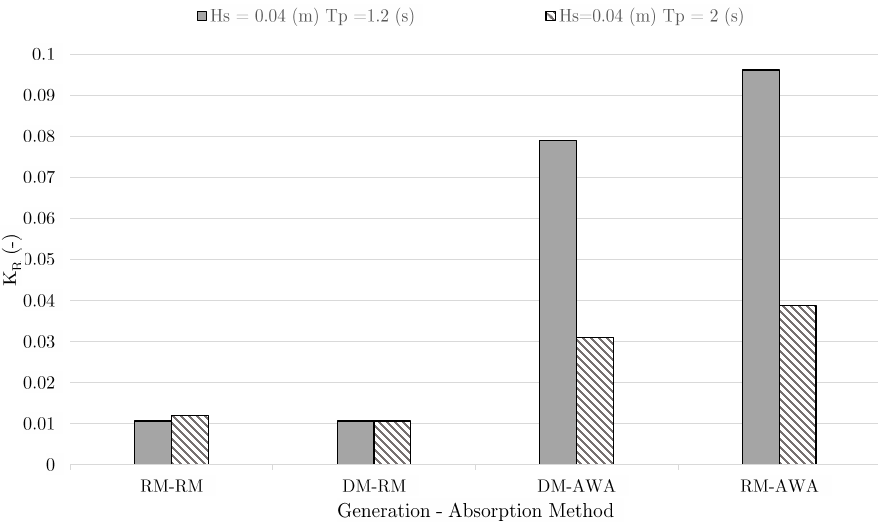
Figure 6. Reflection coefficients for all the different method combinations for irregular